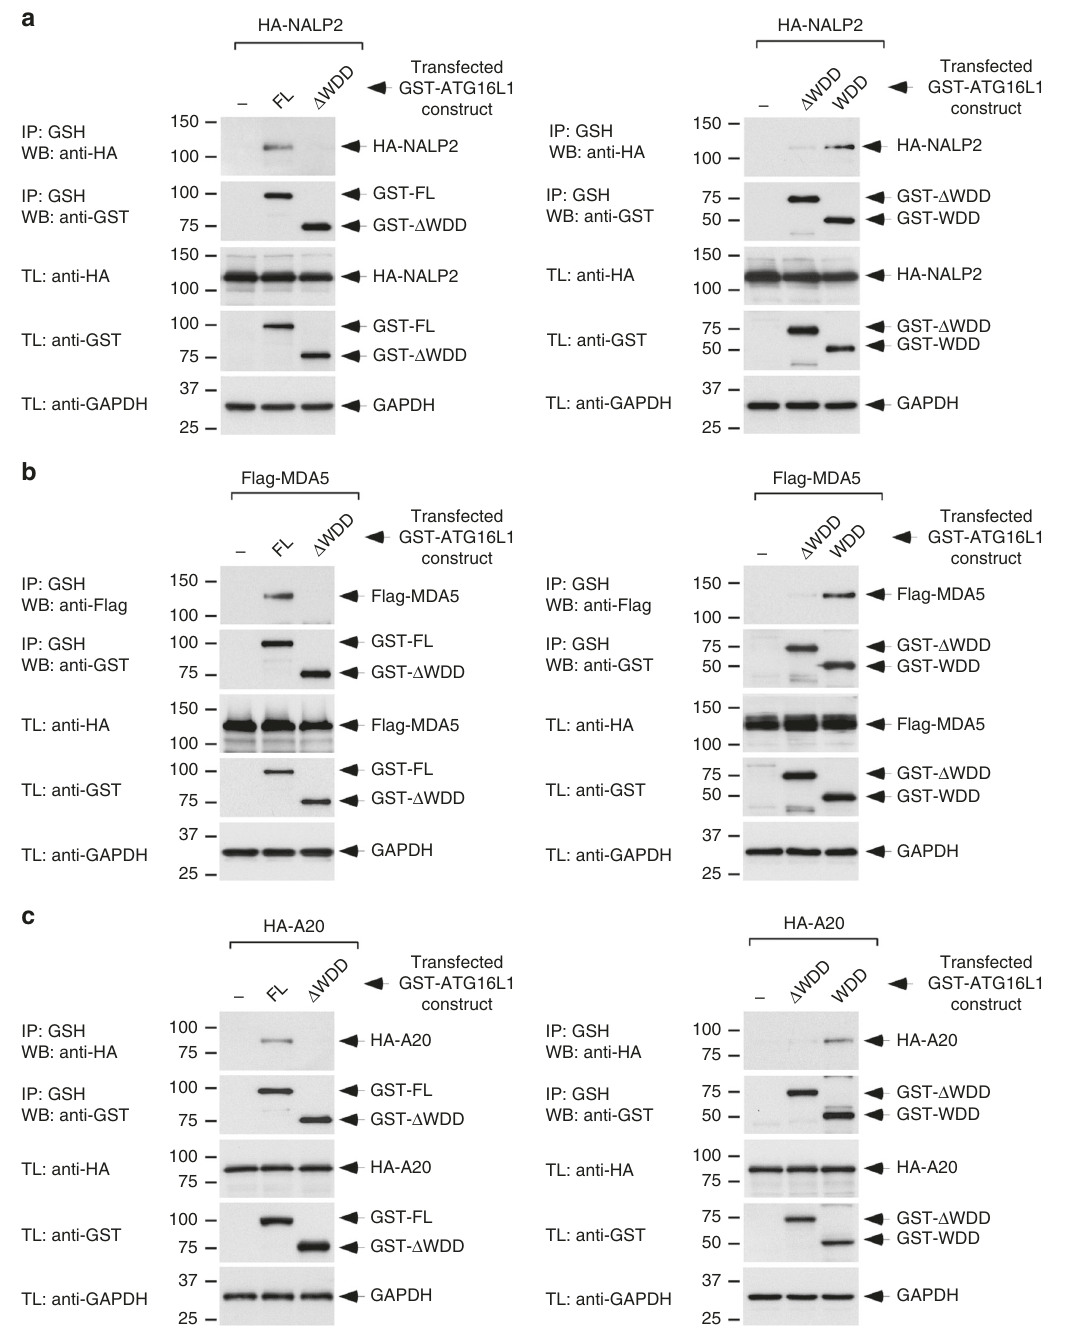
Fig. 2 NALP2, MDA5, and A20 bind the WDD of ATG16L1 in co-precipitation assays. a – c HEK-293T cells were transfected with the indicated constructs (WDD, residues 320 – 607 of ATG16L1; Δ WDD, 1 – 299), lysed 36 h after transfection and subjected to GST immunoprecipitation using agarose beads coupled to glutathione (IP: immunoprecipitation; TL: total lysate). Shown are Western-blots against the indicated